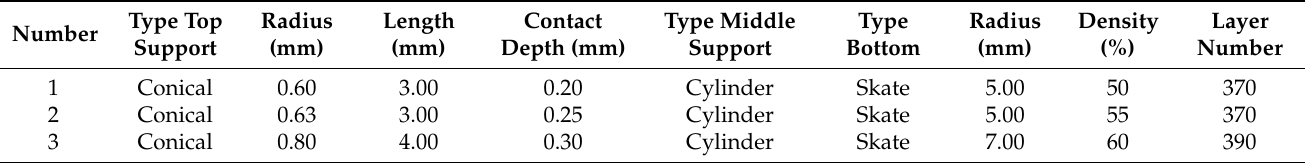
Table 1. The input data for the generation of the part.